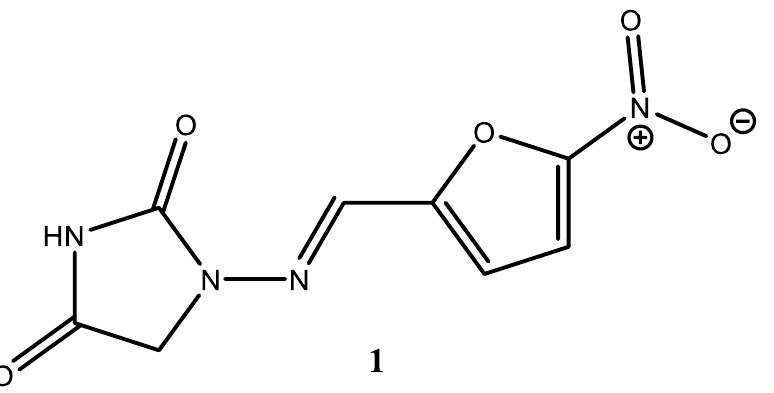
Figure 1. Structural formula of nitrofurantoin 1 .